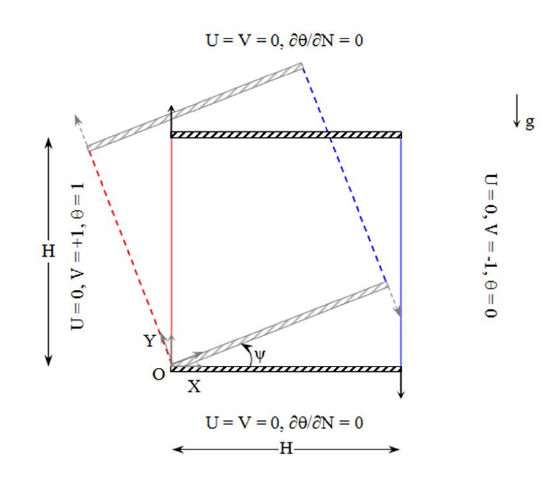
Figure 1: Simulation domain with its boundary conditions.